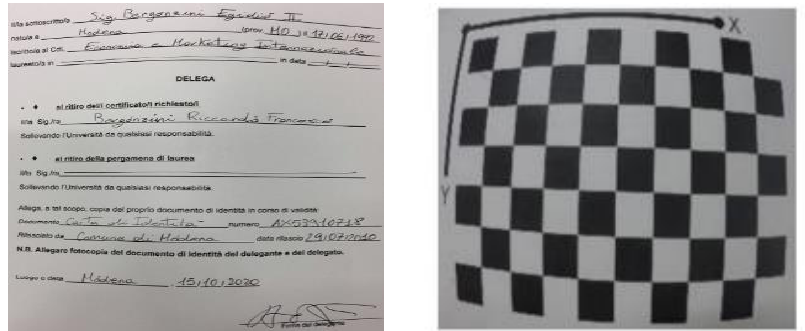
Figure 6. Example of selecting the corresponding checkerboard pattern.